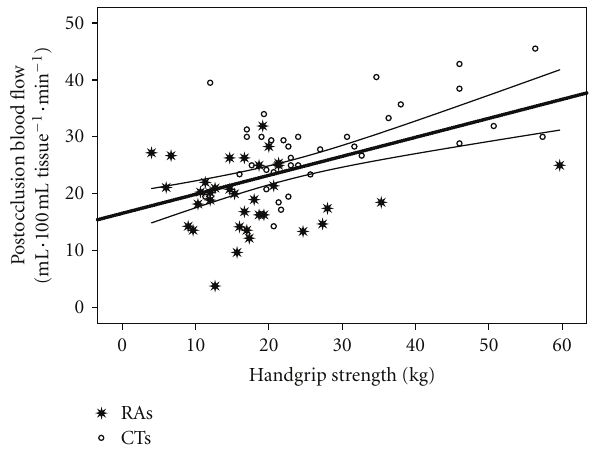
Figure 3: Relationship between handgrip strength and postocclu- sion forearm blood flow. r = 0 . 5; P = 0 . 0001.